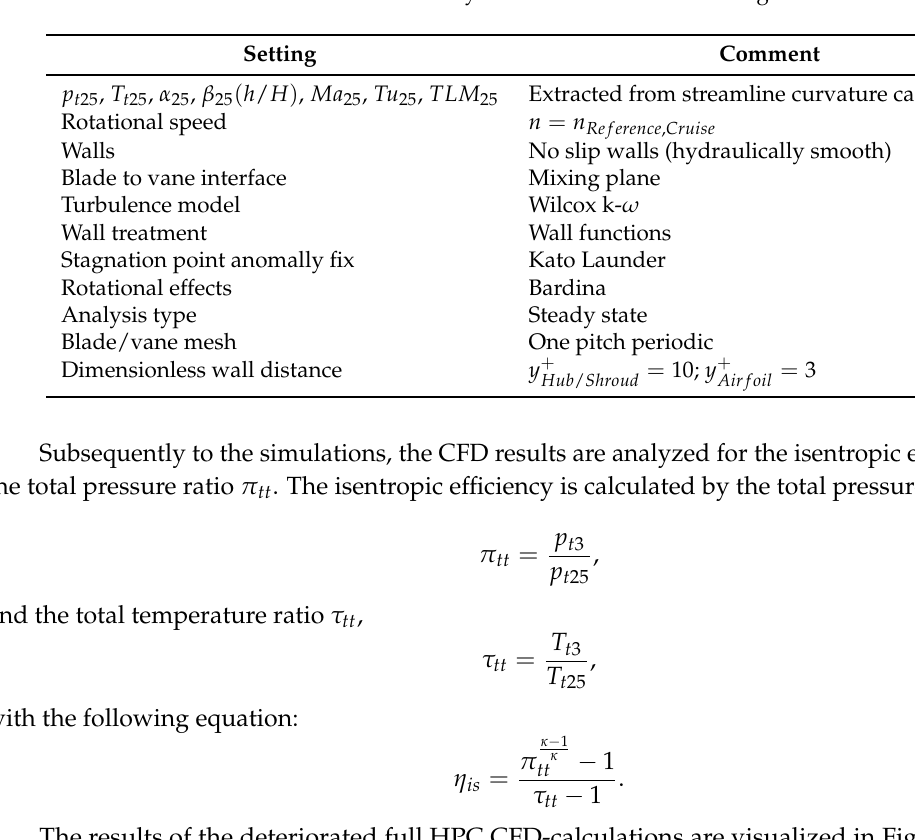
Table 2. Boundary conditions and solver